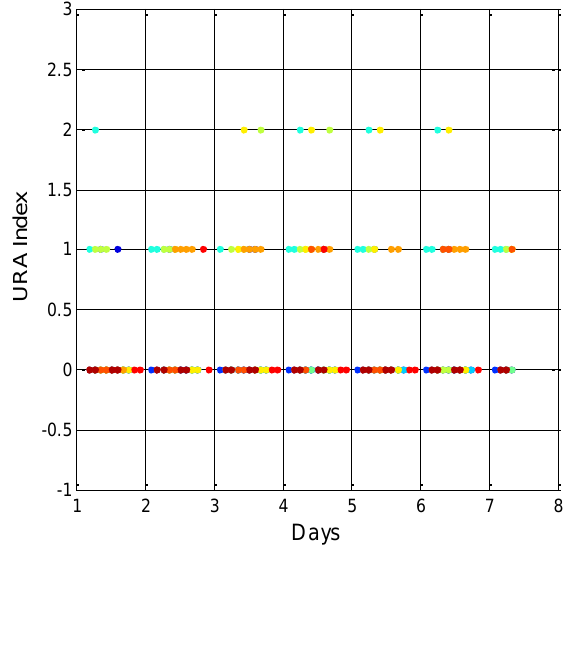
Figure 5. The broadcasted GPS URA index values for one